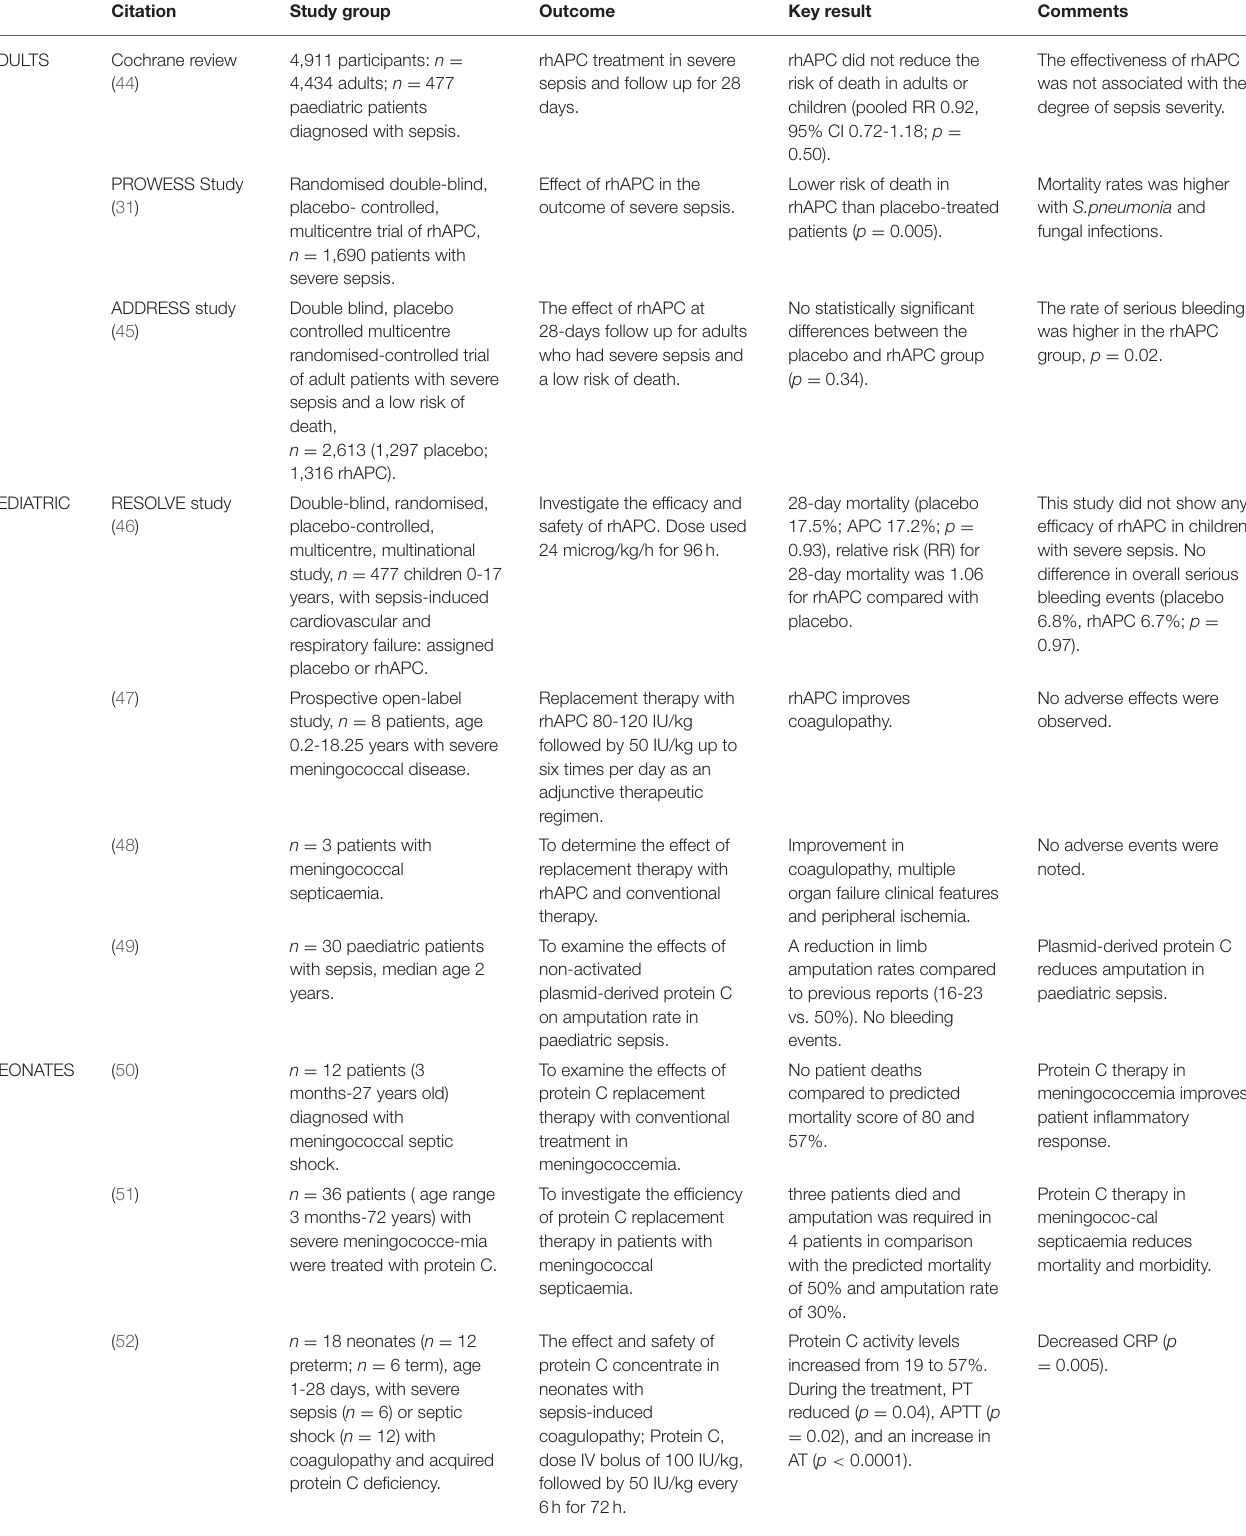
TABLE 1 | Protein C as a treatment in